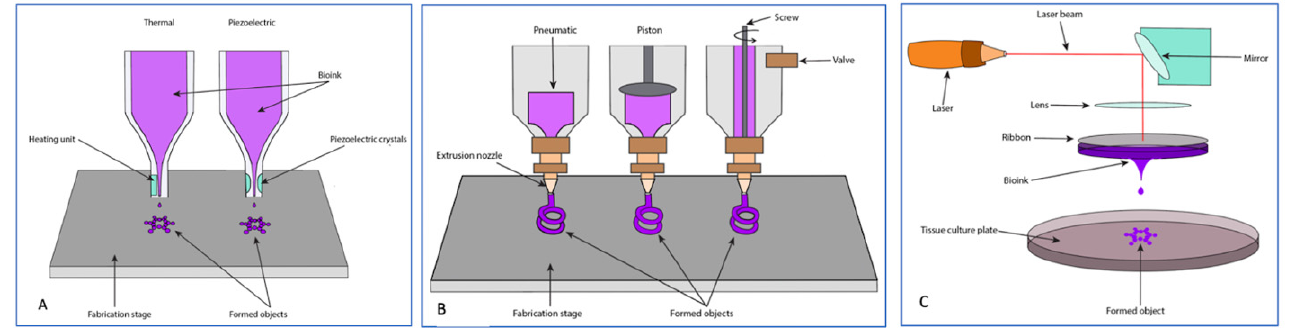
Figure 5. ( A ) Thermal and piezoelectric inkjet printing. ( B ) Ink extrusion bioprinting. ( C ) Laser- assisted bioprinting.